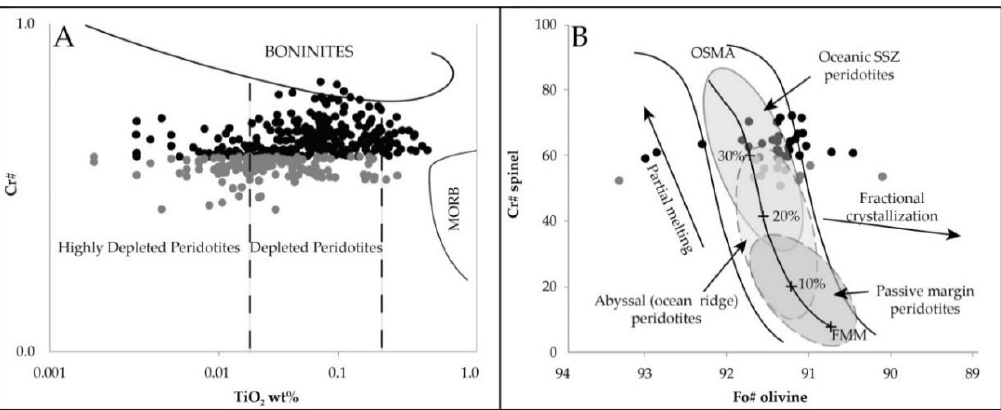
Figure 11. Plot of analyzed samples from Jayapura: ( A ) TiO 2 vs. Cr# for chromian spinel (after [57]); ( B ) Olivine-spinel mantle array Cr# spinel vs. Fo# olivine (after [56]). Black dots: high-Cr spinels, grey dots: high-Al spinels.